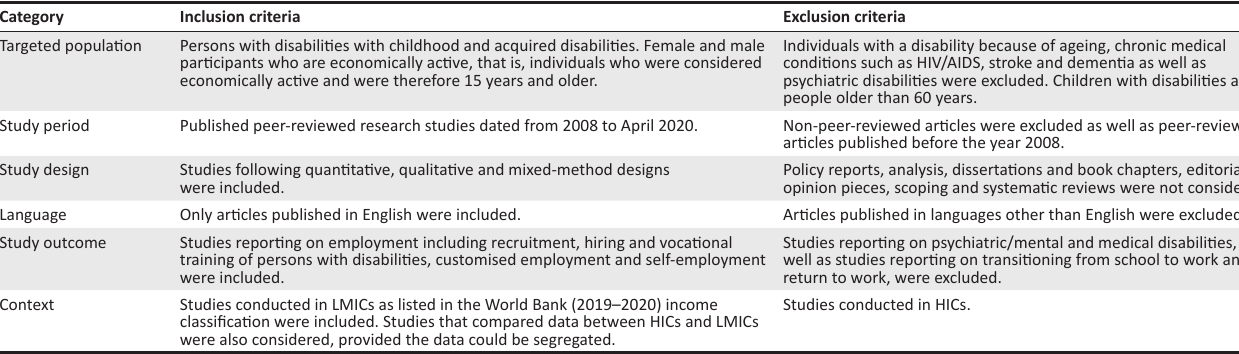
TABLE 1: Inclusion and exclusion